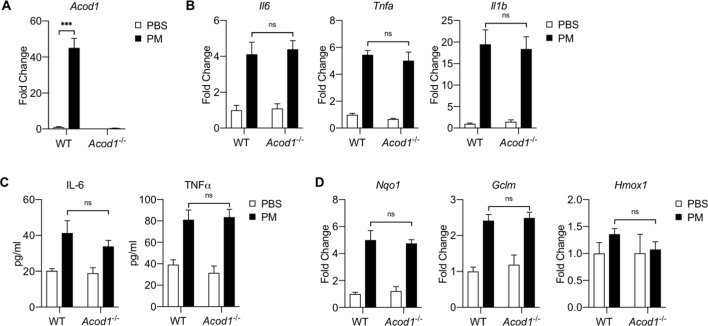
Acod1 and Itaconate are not required for PM-induced inflammation in an in vivo model of PM exposure.WT and Acod1-/-mice were treated intratracheally with PM (100 μg) or PBS and 24 hours later, bronchoalveolar lavage (BAL) fluid was collected to obtain alveolar macrophages and cytokine levels in fluid. (A) Acod1 gene expression is induced in alveolar macrophages by in vivo PM treatment in WT mice as measured by qPCR. (B) Inflammatory genes (Il6, Tnfa, Il1b) as measured by qPCR were equally upregulated by PM treatment in vivo in both WT and Acod1-/- mice. (C) Cytokine levels of IL-6 and TNFα in BAL fluid as measured by ELISA; IL-6 and TNFα levels increase equally with PM treatment in both WT and Acod1-/- mice. (D) NRF2 target genes (Nqo1, Gclm, Hmox1) were upregulated with PM treatment as measured by qPCR, with no difference between WT and Acod1-/- mice. Significance was analyzed with one-way ANOVA corrected with Bonferroni’s post hoc test for multiple comparisons, n = 6; *p<0.05, **p<0.01, ***p<0.001.